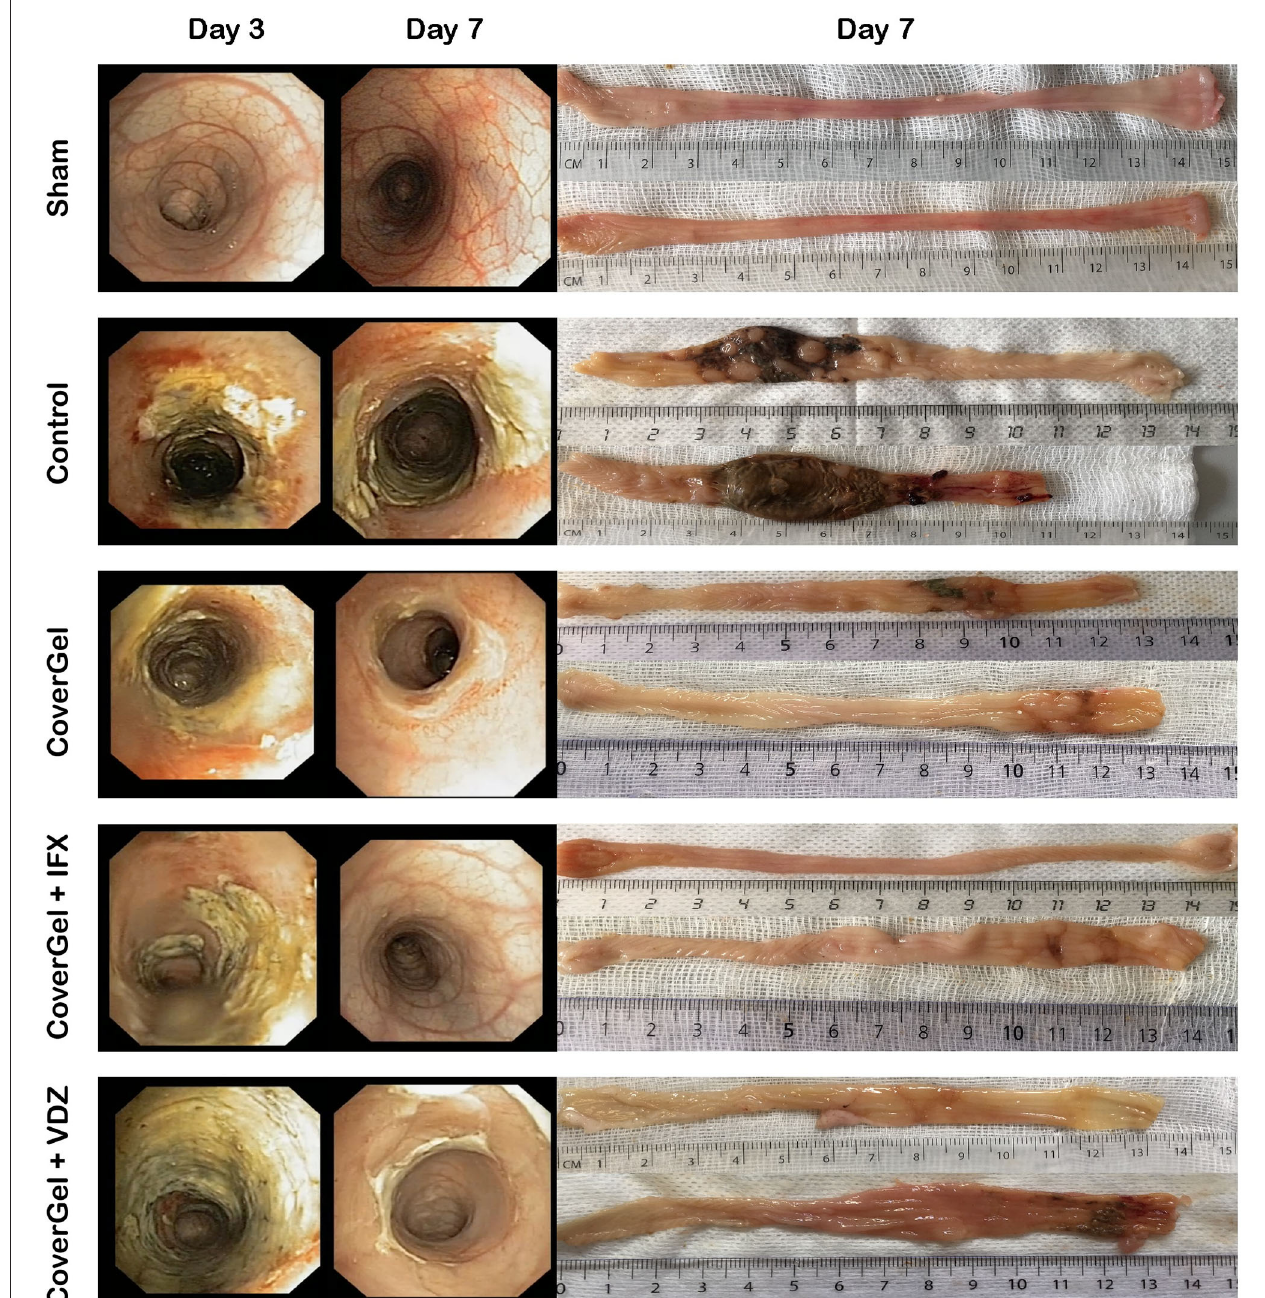
FIGURE 5 | Endoscopic and macroscopic representative images of the acute EC animal model. Endoscopic images from day 3 (day of treatment) and day 7 (day of euthanasia) and macroscopic image of day 7 (day of euthanasia) from two representative animals of each group.